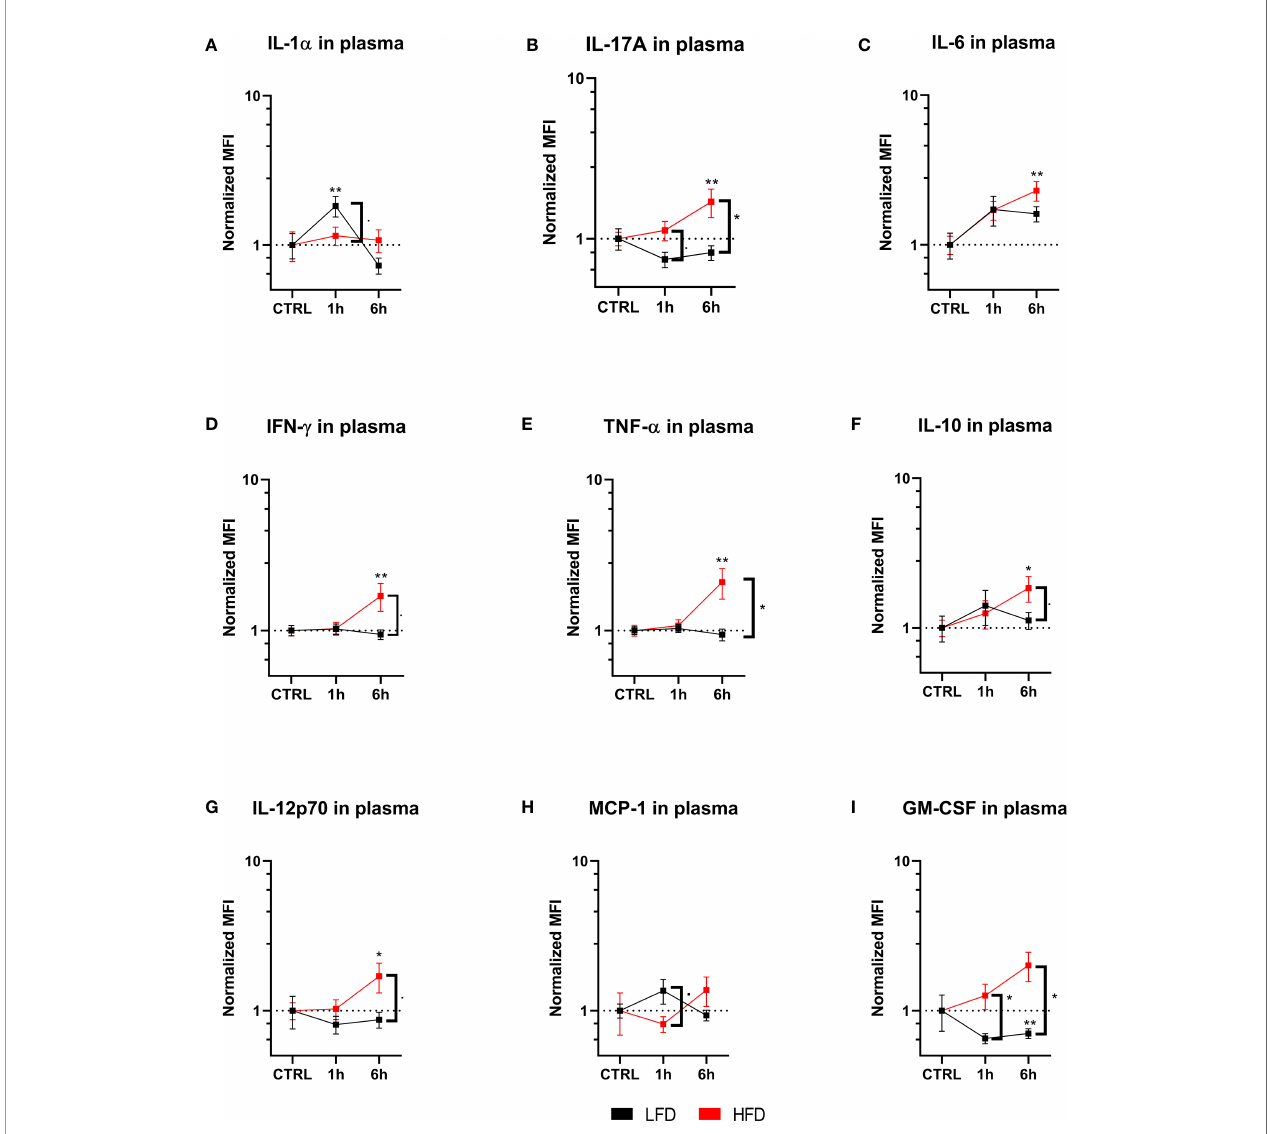
FIGURE 5 | Immunoplex assays analyzing various pro-in fl ammatory molecules in plasma during the early response up to 6 h. Timelapse showing the level of IL-1 a (A) , IL-17A (B) , IL-6 (C) , IFN g (D) , TNF-a (E) , IL-10 (F) , IL-12p70 (G) , MCP-1 (H) and GM-CSF (I) . depicted as mean fl uorescence intensity (MFI) and normalized to the respective control. Statistics: two-way ANOVA with an uncorrected Fisher ’ s LSD test as follow-up was used to compare the level to the respective CTRL, signi fi cance indicators are displayed directly above the bar; unpaired two-tailed Student ’ s t -test was used for comparison of lean and obese mice at a speci fi c time point, signi fi cance indicators are displayed next to the connector line. ▪ indicates p ≤ 0.1, * indicates p ≤ 0.05, ** indicates p ≤ 0.01. Sample sizes: Each group at each time point: n = 5. Data are displayed as mean ±